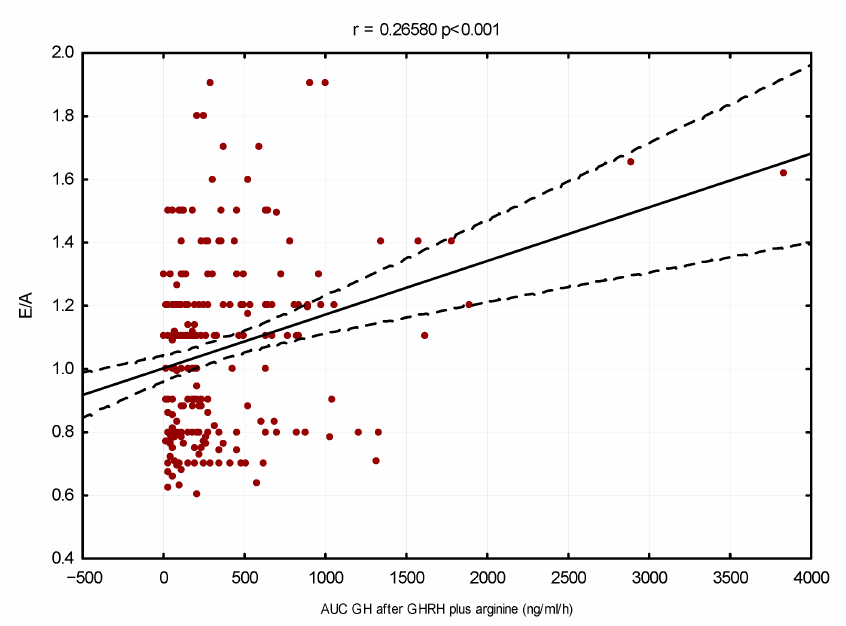
Figure 3. Linear regression between E/A and GH secretory capacity (AUC. ng/mL/hour)–adjusted for age, sex and